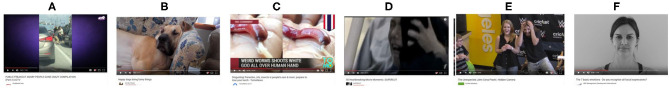
Screenshots of video clips to induce specific emotions in SASE-FE database (Copyright permission is obtained from Kulkarni et al., 2018). These video stimuli contain either specific scenes (such as A,D,E), objects (such as B,C), or the target emotions themselves (such as D–F) for emotion elicitation.